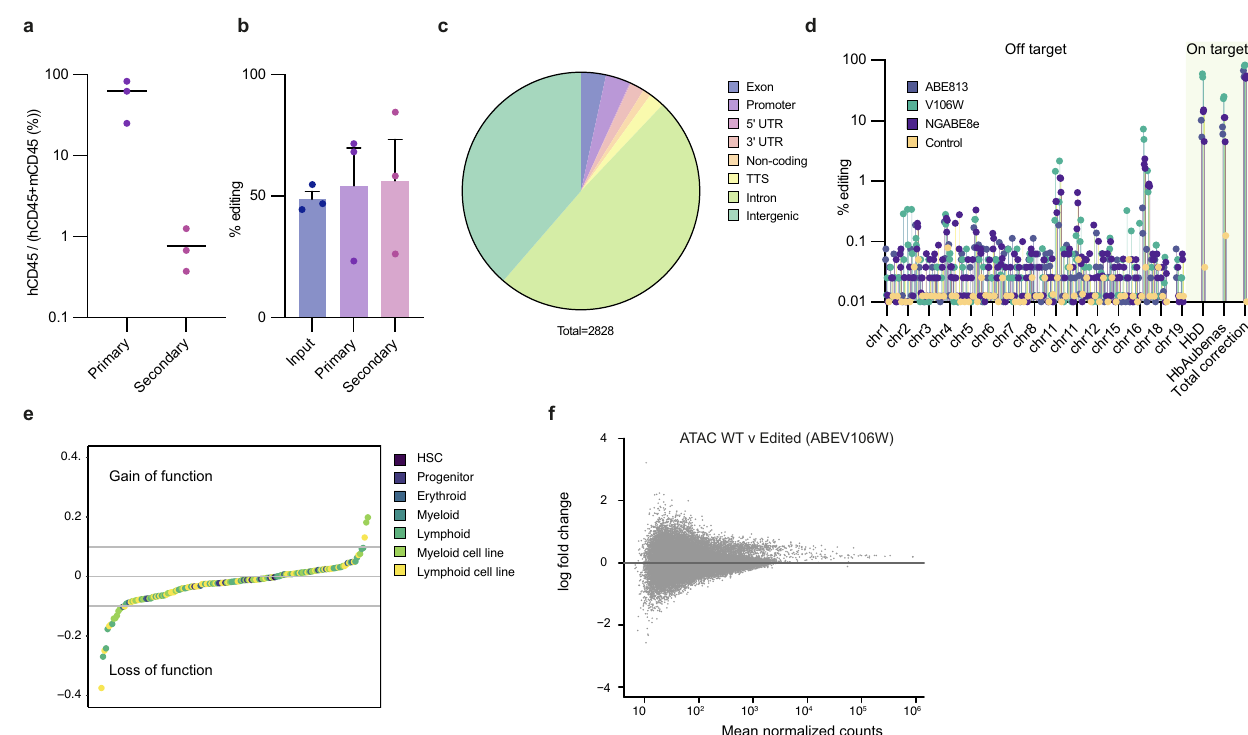
CIRCLE-seq combined with two in silico approaches (Cas-OFFinder and CRISPOR). d Targeted sequencing through oligonucleotide capture at the top 250